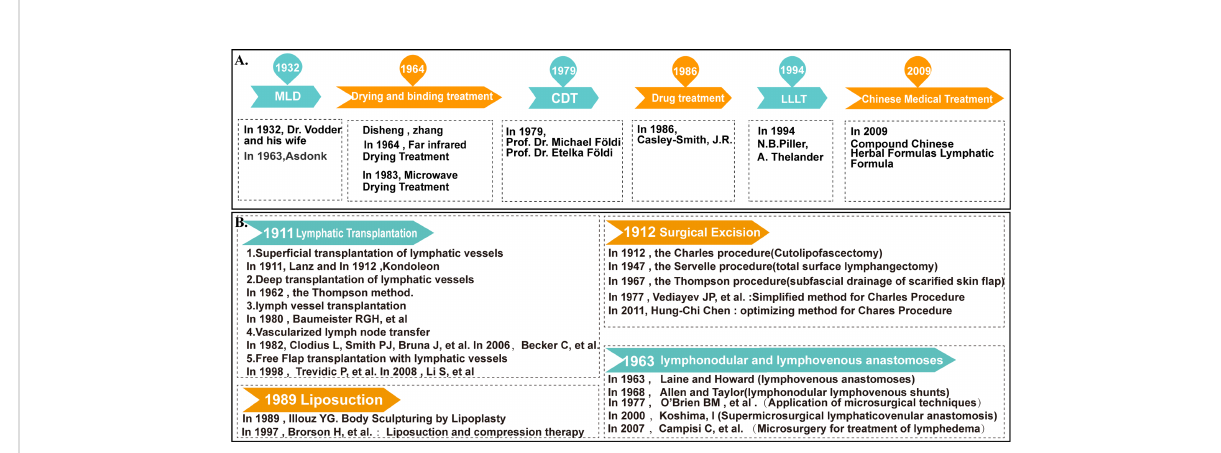
FIGURE 12 The development history of surgical and non-operative treatment of lymphedema. (A) The development history of non-operative treatment of lymphedema. (B) The development history of surgical treatment of